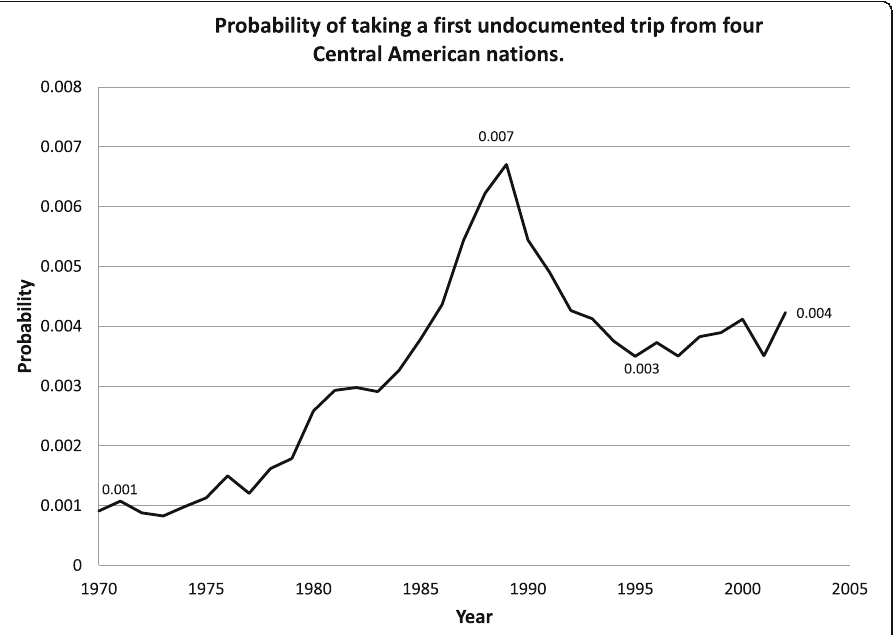
Fig. 21 Probability of taking a first undocumented trip from four Central American